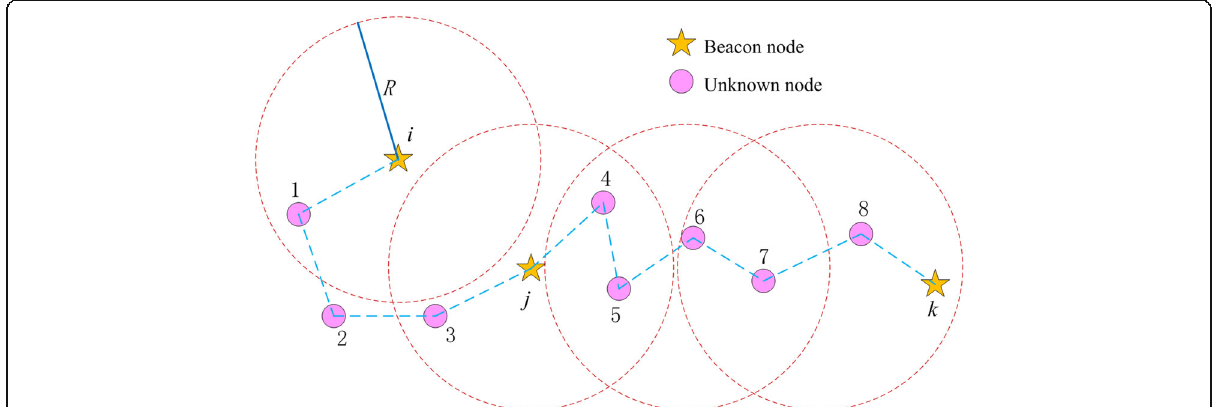
Fig. 3 Network topology diagram for an example